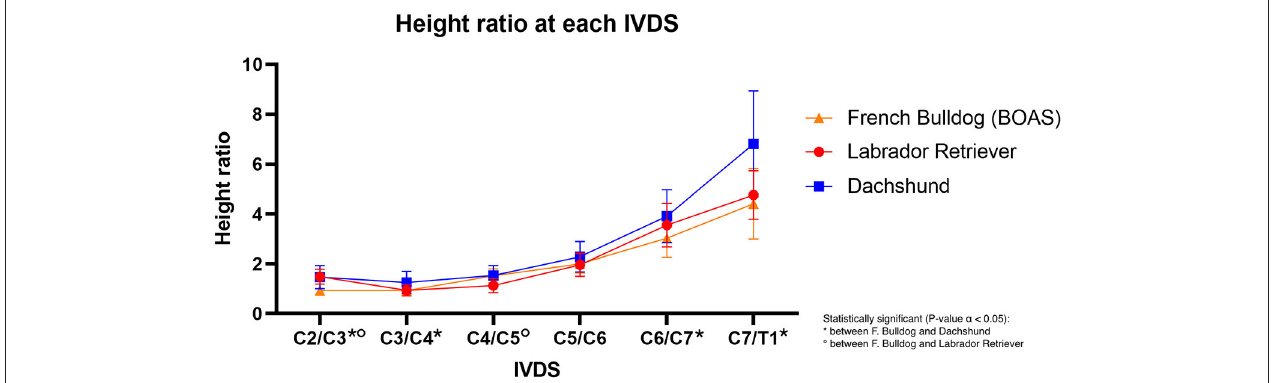
FIGURE 10 | Line graph showing the mean dorsal-to-ventral height ratio of the cervical paraspinal musculature in French bulldogs (orange line), Labrador retriever (red line), and dachshund (blue line).